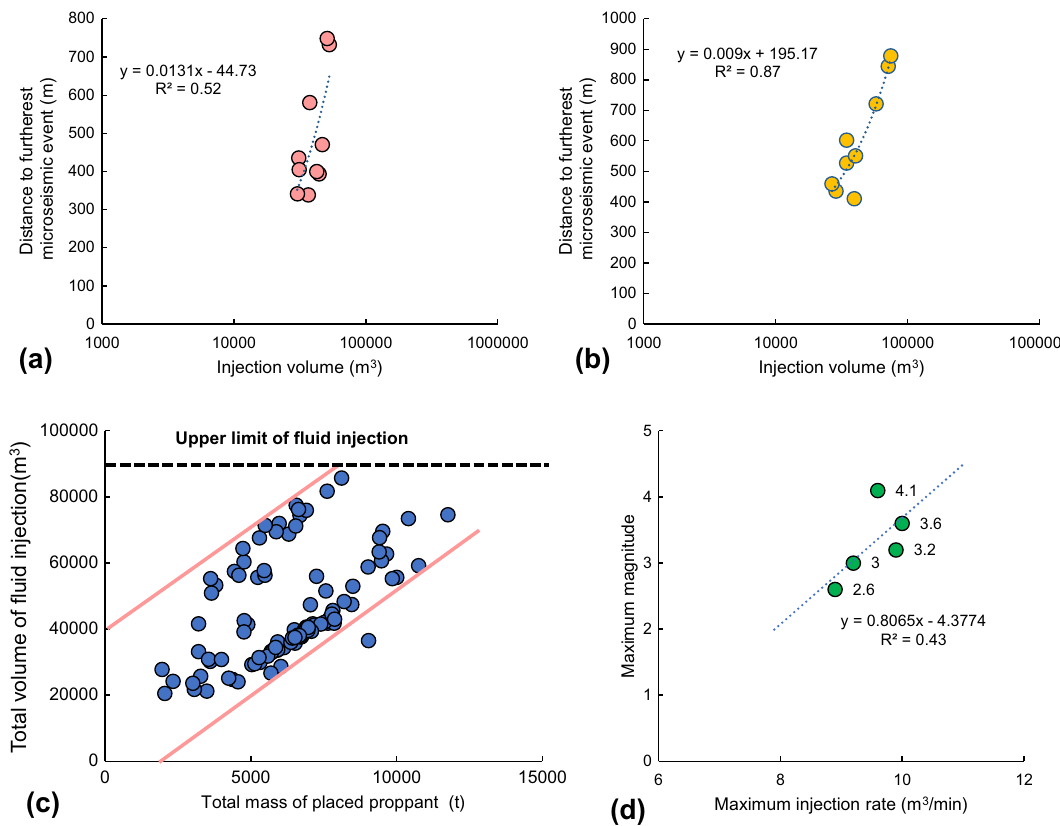
Figure 6. ( a,b ) Distances to the farthest microseismic events vs. fluid injection volumes for N–S-oriented wells and for NW–SE-oriented wells 19 . ( c ) The total volume of fluid injected vs. total mass of placed proppants per well based on the fracturing data for the region studied. ( d ) The maximum magnitude vs. maximum injection rate in five